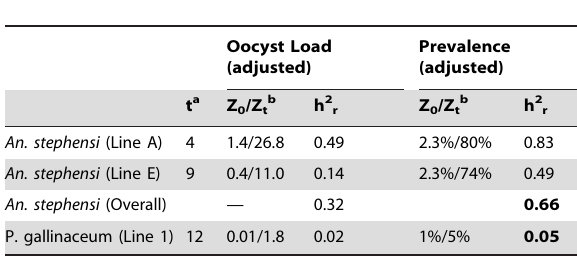
Table 1. Effect of selection on mean oocyst load and prevalence of An. stephensi and P. gallinaceum and their realized heritability (h 2 r